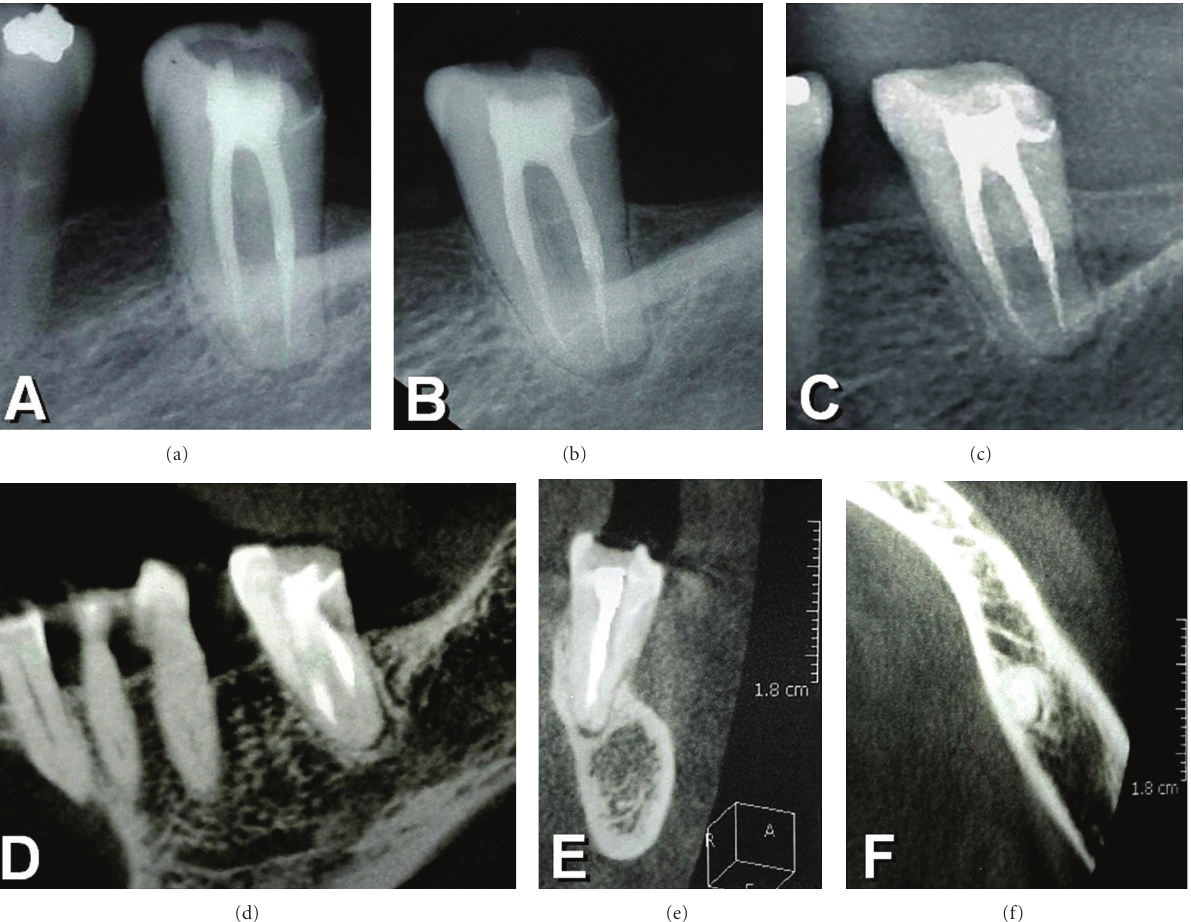
Figure 1: 10-year recall radiograph of a left mandibular second molar showing root canals filled with gutta-percha and EndoREZ sealer. (a) Immediate postoperative radiograph of the left mandibular second molar showing root canals filled with gutta-percha and EndoREZ sealer. (b) 8-year recall. (c) 10-year recall. Note the presence of a small residual periapical radiolucent area surrounded by thick cortical bone and normal bone trabeculae. After 10 years the patient was asymptomatic and radiographically the case was evaluated as successful and suggest the presence of an apical scar. (d) Lateral, (e) distal, and (f) occlusal CBCT images confirming the radiographic